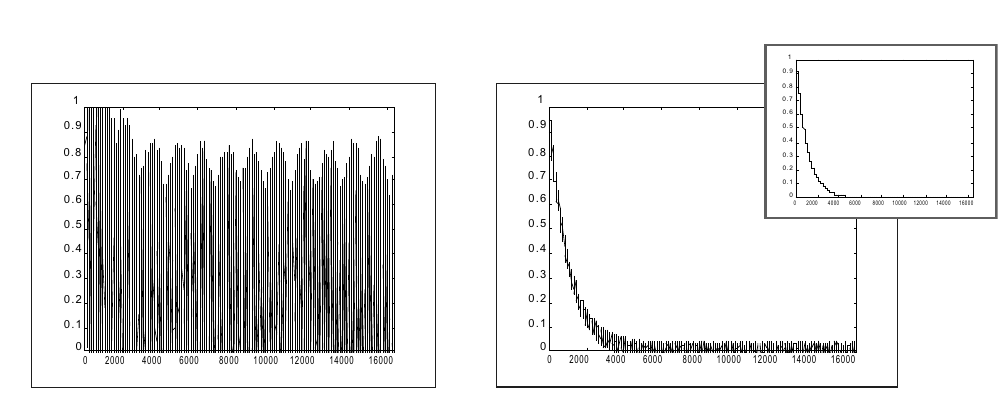
Fig. 5. Simulation results. On the left side: the received signal r ( t ). For the test the noise was modelled as the sum of two sinusoids with a maximum amplitude equal to 0.6, an AWGN with a maximum amplitude equal to 0.2 and a spike with a maximum amplitude equal to 0.3 and a duration of 500 µ s. On the right side: the processed signal obtained after filtering and compressing procedures; in the small window: the original signal s ( t